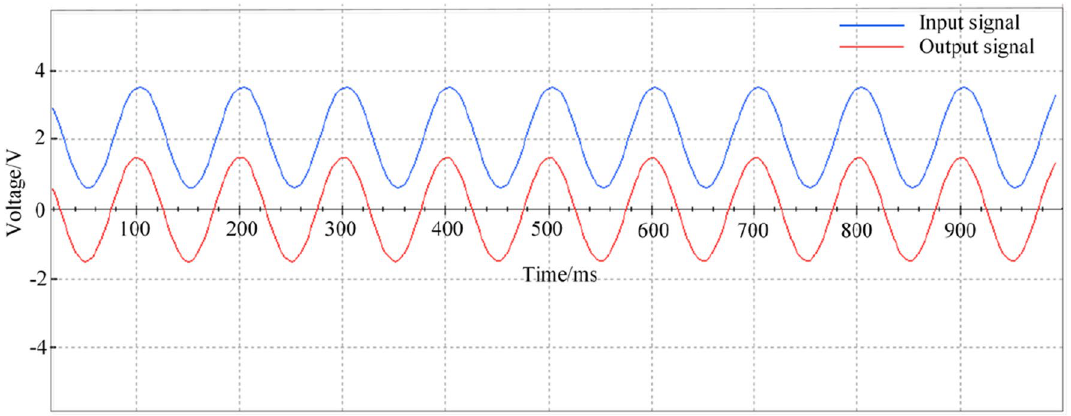
Figure 4. The input signal and output signal diagram of the signal conditioning